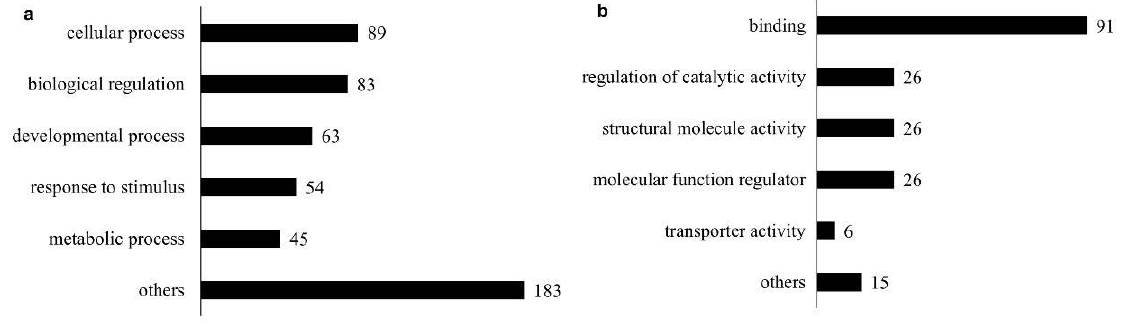
Figure 3. Mapping of the identified healthy mouse kidney matrisome proteins against GO terms using Uniprot database: ( a ) GO terms for the Biological Process and ( b ) GO terms for the Molecular